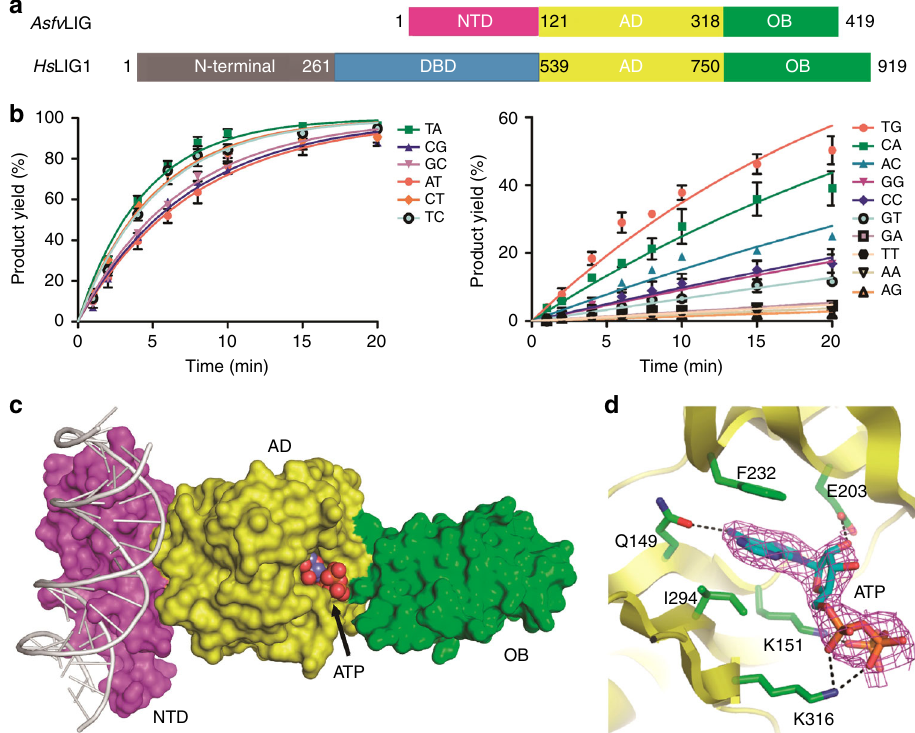
Fig. 1 Domain architecture and ATP recognition pattern of Asfv LIG. a Schematic view comparing the domain compositions of Asfv LIG and Hs LIG1. b In vitro DNA ligation catalyzed by wild-type Asfv LIG. Data represent the mean of three independent experiments, the standard deviation (SD) values are indicated by error bars. c Overall fold of the non-catalytic Asfv LIG:DNA complex. Asfv LIG is shown as surface with the NTD, AD, and OB domains colored in magenta, yellow, and green, respectively. DNA and ATP are shown as cartoons and spheres in white and atomic colors (C, light-blue; N, blue; O, red; P, orange), respectively. d Cartoon-and-stick view showing ATP recognition by the Asfv LIG AD domain. ATP is shown as sticks and outlined with simulated annealing 2F o -F c omit map, which is contoured at the 1.5 sigma